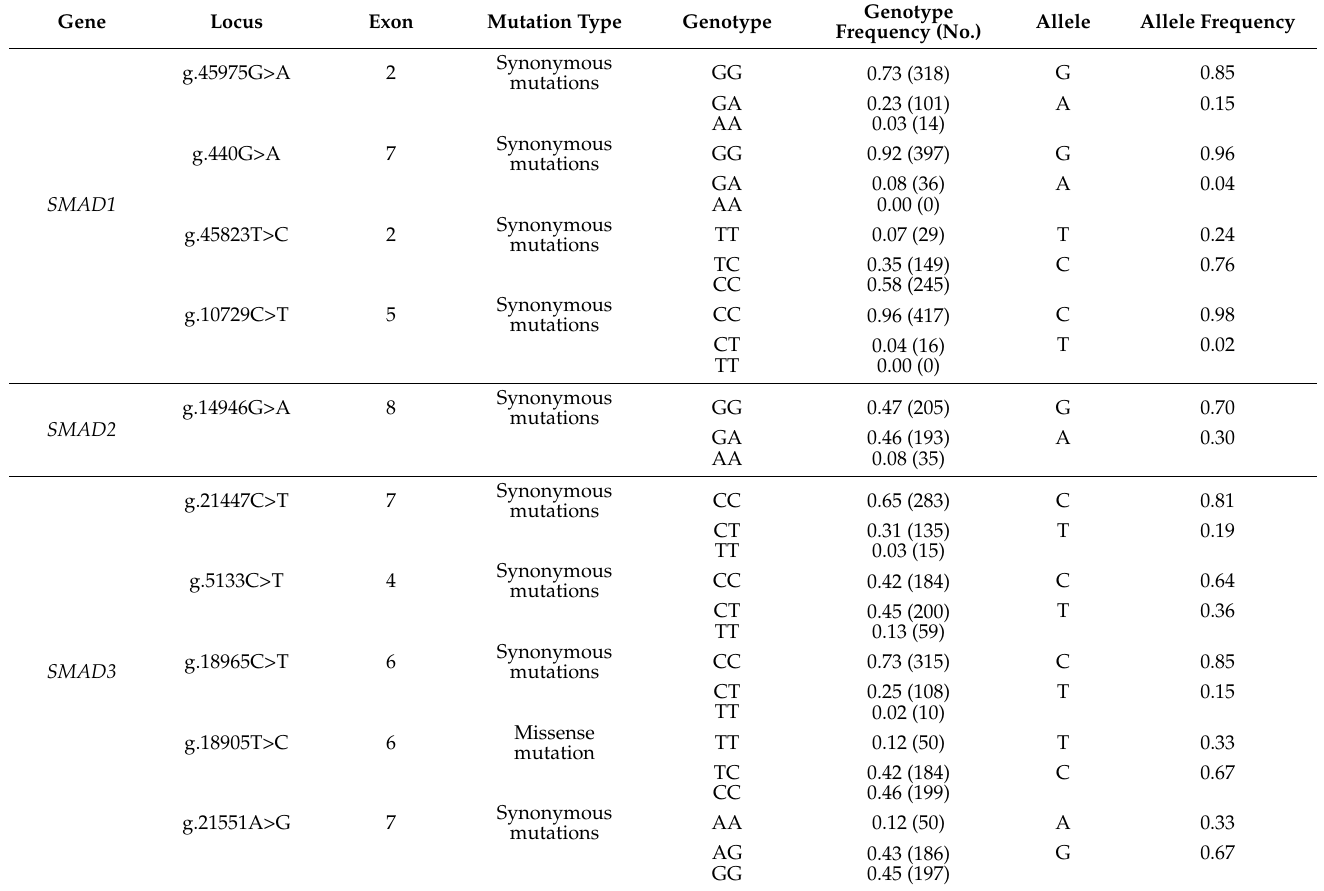
Table 3. Genotype and allele frequencies of SNPs loci of SMAD1 , SMAD2 and SMAD3 genes in Tibetan